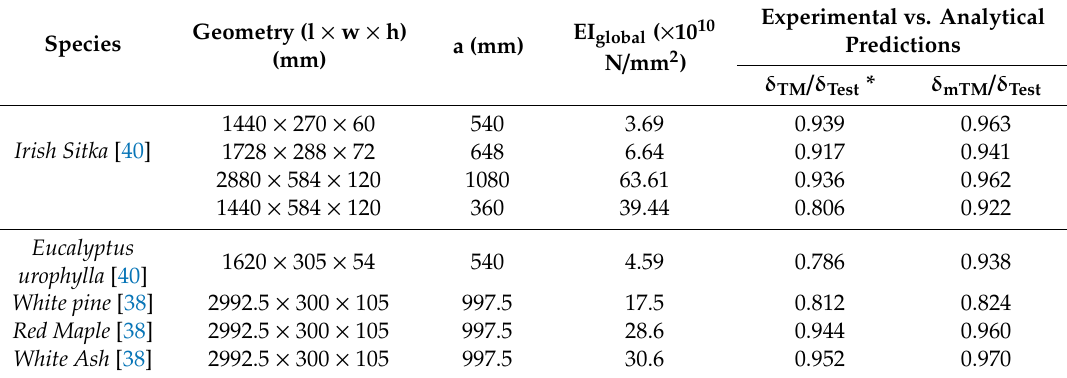
Table 7. Deflection at 20 kN load for four point bending